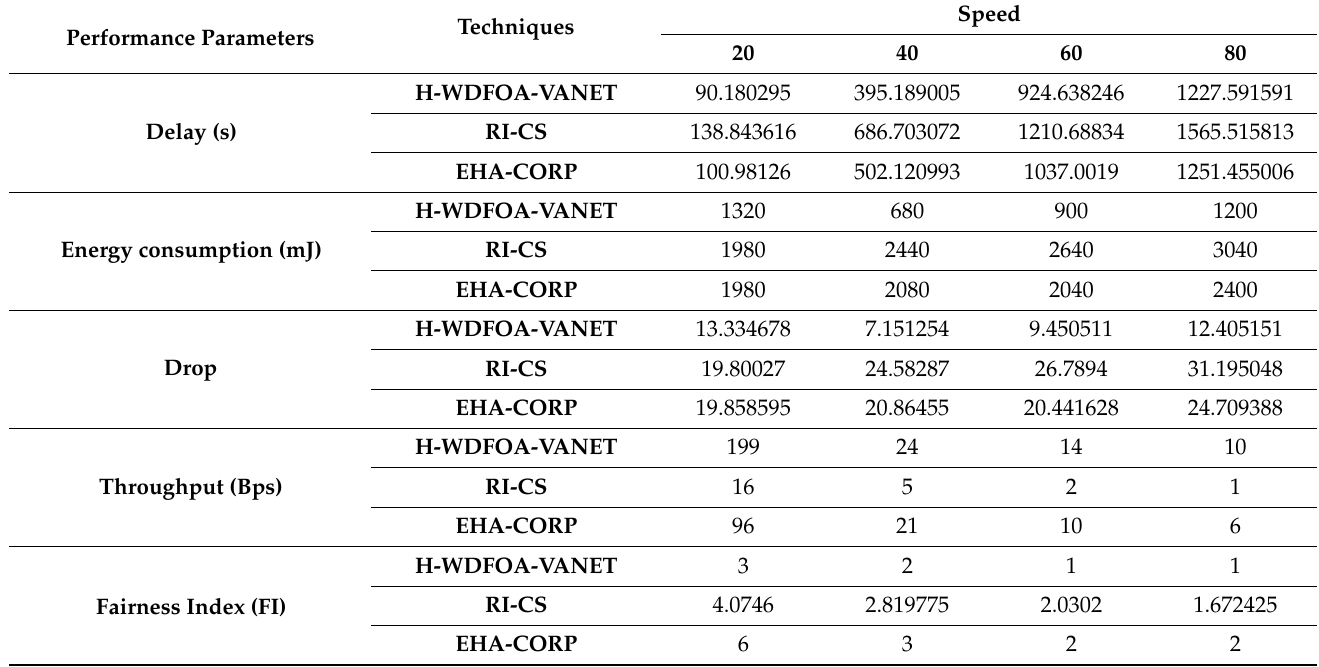
Figure 24. Plots of speed vs. fairness index in the suggested approach and existing approaches. Table 8. Comparative analysis of suggested approach with existing approaches at different